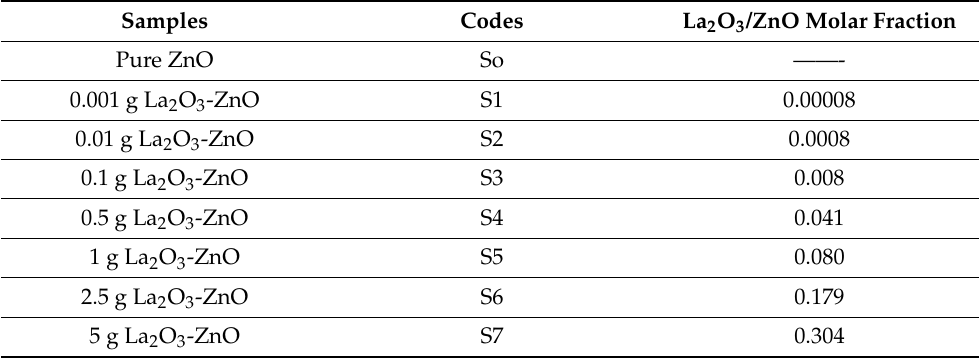
Table 1. ThesamplecodeforLa 2 O 3